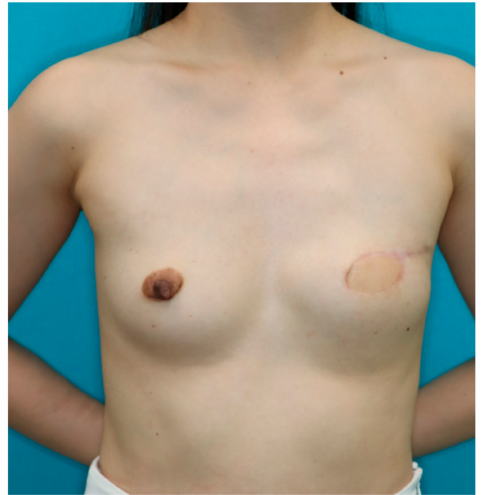
Figure 3. At the 12 months follow-up, the upper pole of the reconstructed breast retained its